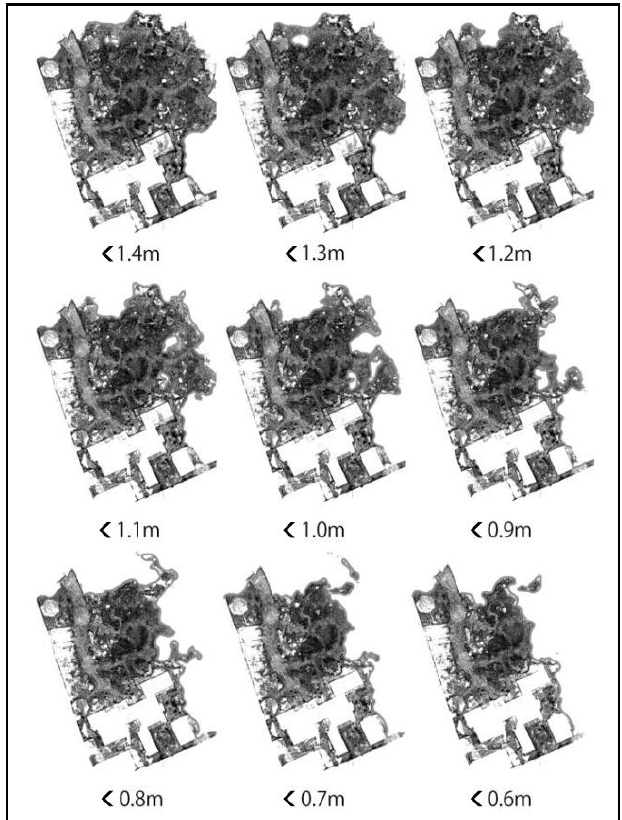
Figure 7. The height classification of Matsumoto Gokichi Old House